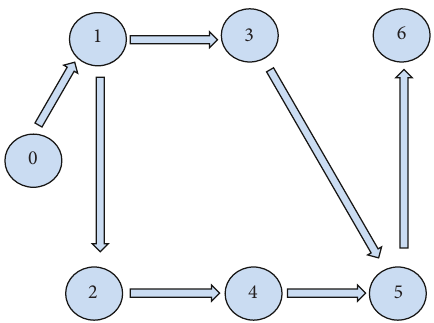
Figure 1: The interaction topology among